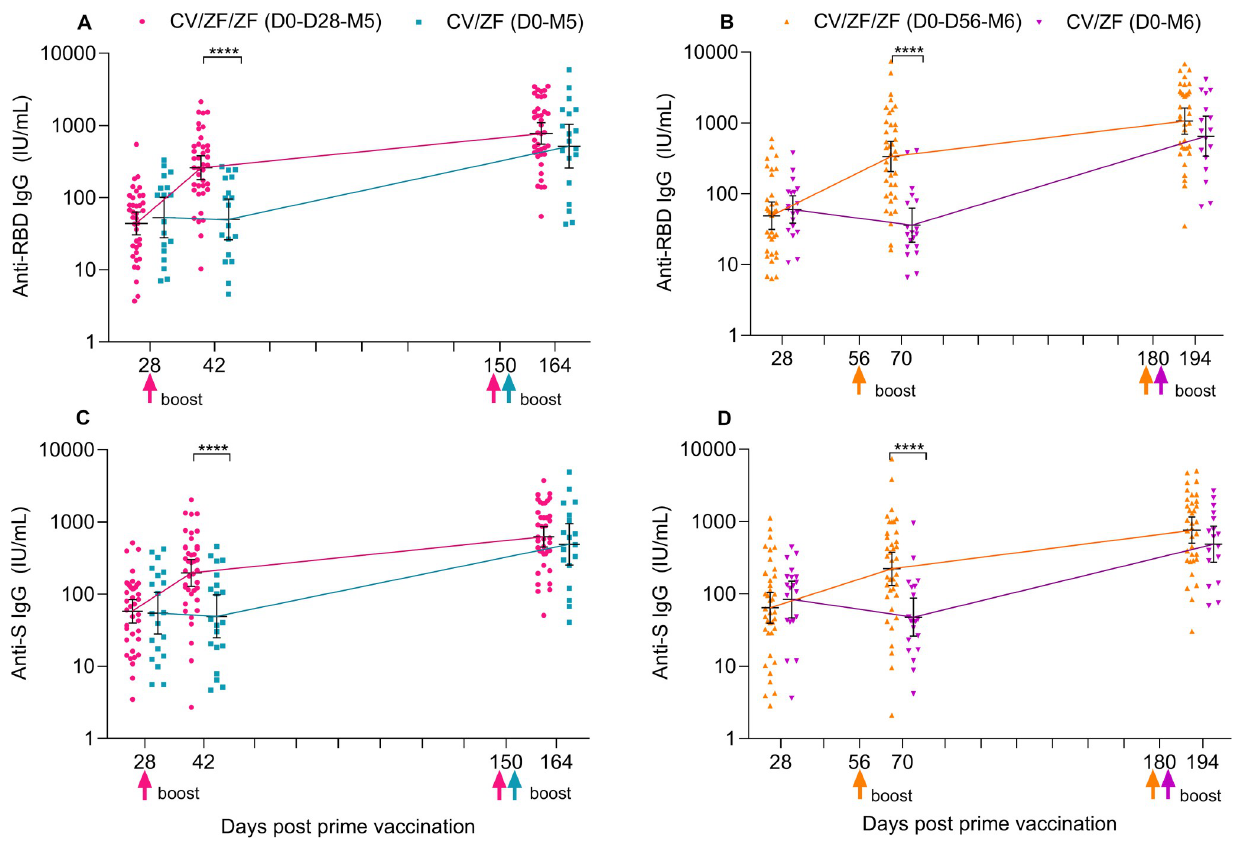
Fig 4. SARS-CoV-2-specific IgG antibodies after prime and boost dose. ( A and B ) GMTs of anti-RBD IgG ( A and B ) and anti-spike IgG ( C and D ) 28 days after prime dose, 14 days after first and second boost dose. Horizontal bars show geometric mean concentration and error bars show 95% CI. Up arrow represents the boost immunization. ���� P < 0.001. RBD = SARS-CoV-2 receptor-binding domain. IU/ml = International units per milliliter. CV/ ZF/ZF (D0-D28-M5) = receiving Convidecia/ZF2001/ZF2001 at day 0, day 28, and month 5; CV/ZF (D0-M5) = receiving Convidecia/ZF2001 at day 0 and month 5; CV/ZF/ZF (D0-D56-M6) = receiving Convidecia/ZF2001/ZF2001 at day 0, day 56, and month 6; CV/ZF (D0-M6) = receiving Convidecia/ ZF2001 at day 0 and month 6. CI, confidence interval; IgG, immunoglobulin G; RBD, receptor-binding domain; SARS-CoV-2, Severe Acute Respiratory Syndrome Coronavirus 2. S3 Figs). Strong correlations were found between neutralizing antibodies against wild-type and anti-RBD IgG, and neutralizing antibodies against wild-type and anti-spike IgG at 14 days post second boost dose (Pearson correlation coefficients of 0.87 to 0.92) (S4 Fig).